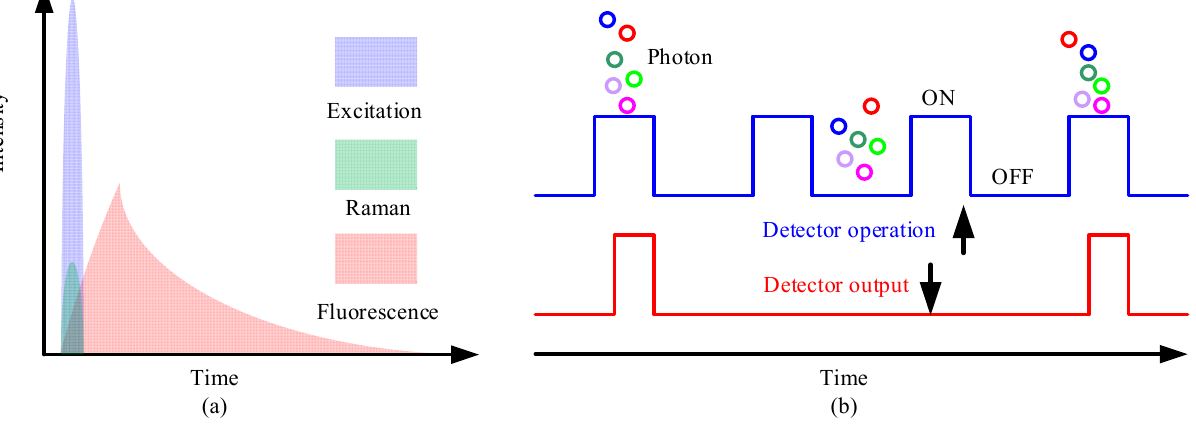
Figure 8. ( a ) Temporal variation of excitation, Raman scattering and fluorescence emission; ( b ) Time-gated operation of